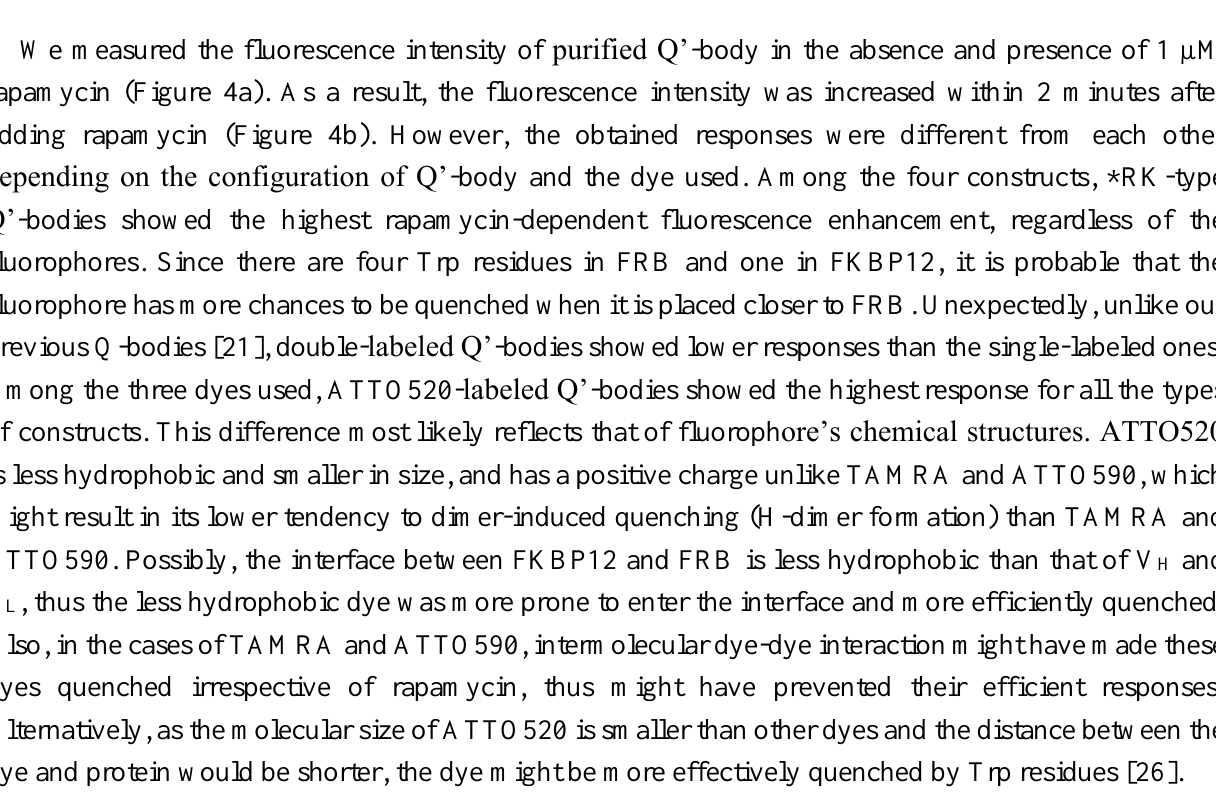
Figure 3. Fluorescence image of ( a ) ATTO520-; ( b ) tetramethylrhodamine (TAMRA)-; and ( c ) ATTO590-incorporated Q’-bodies. Scheme above each gel is the chemical structure of the dye